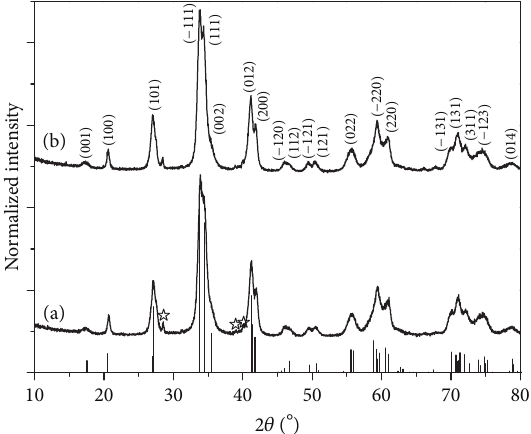
Figure 1: XRD patterns of the samples prepared with reagents in stoichiometric proportion, varying the time of synthesis: (a) 20 min and (b) 60 min. Bars represent the wolframite structure of CdWO 4 (some crystalline planes are indexed according to [26]) and symbols correspond to WO 3